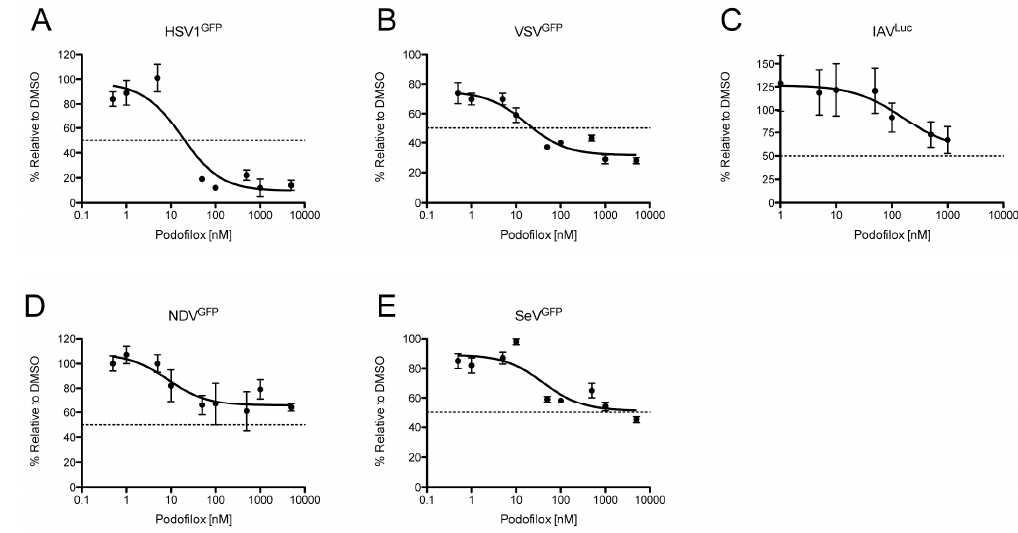
Figure 7. Podofilox inhibition of diverse enveloped viruses. MRC5 cells pretreated podofilox were infected with various reporter viruses and analyzed for GFP fluorescence (HSV1 GFP , VSV GFP NDV GFP , and SeV GFP ) or luciferase activity (IAV Luc ). The number of infected cells was determined using an Acumen e X3 cytometer for HSV1 GFP ( A , 24 h p.i.); VSV GFP ( B , 8 h p.i.); NDV GFP ( D , 24 h p.i.) and SeV GFP